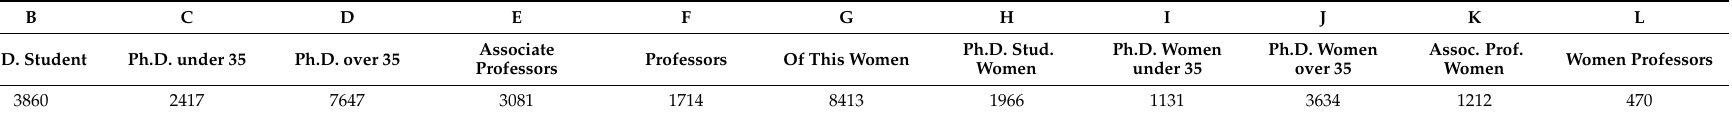
Table 5. Structure of research and development capacities for the year 2020 *.